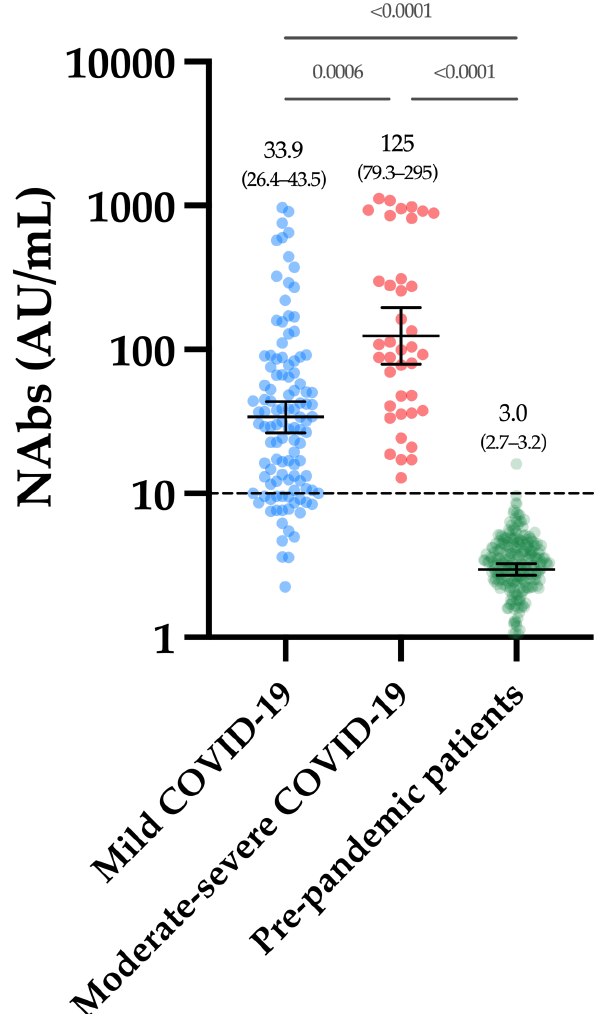
Figure 1. NAb titers obtained in the first group of COVID-19 patients and in the pre-pandemic cohort. The black dotted line corresponds to the positivity threshold of 10 AU/mL. Table 2. Precision of the sVNT using controls and patient samples. All materials were analyzed 10 times in a row.